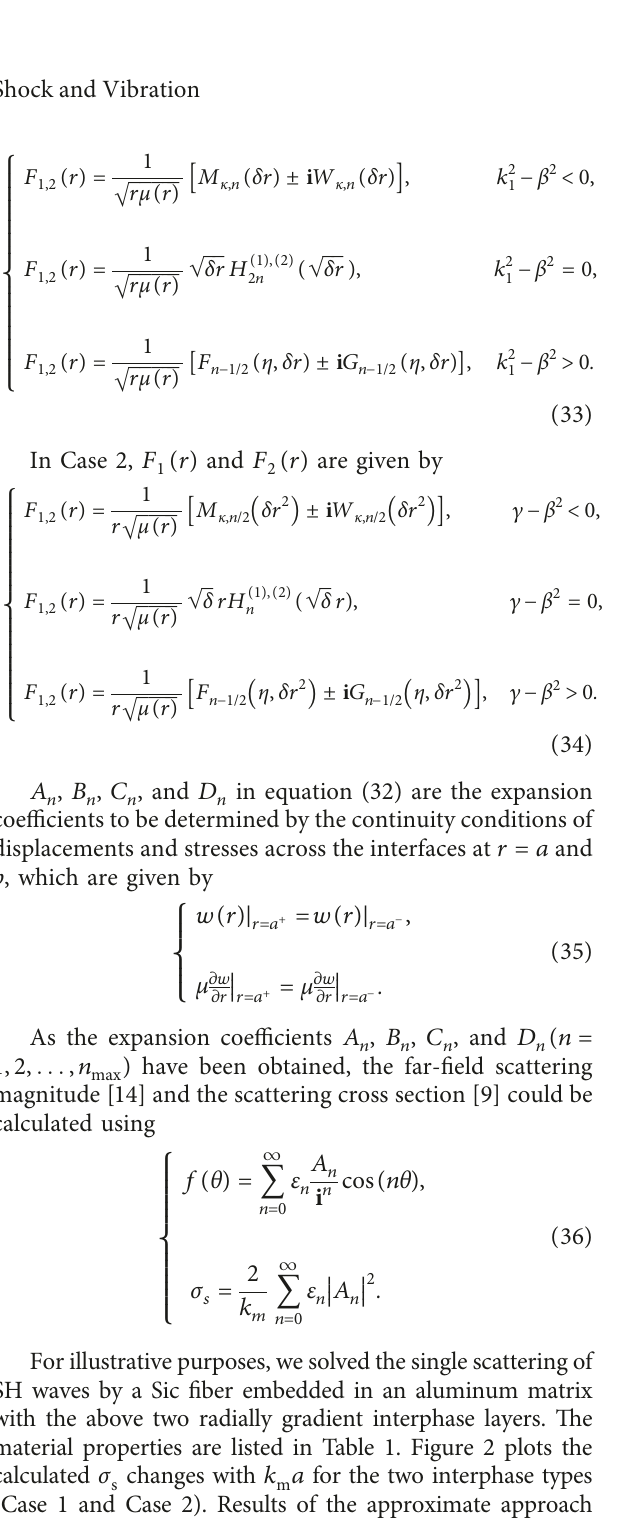
Figure 2: Comparison of σ s between current theoretical solutions and the approximate method for interphase layer types (a) Case 1 and (b) Case 2 at different frequencies. For a comparison, the results for cases without interphase layers were also plotted as the black solid